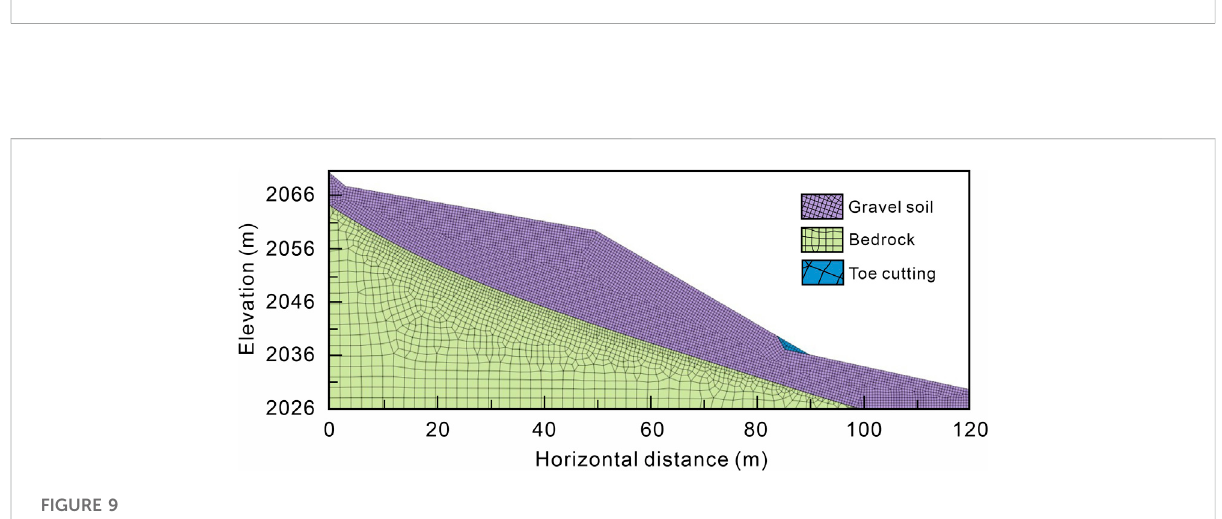
FIGURE 9 Numerical model for